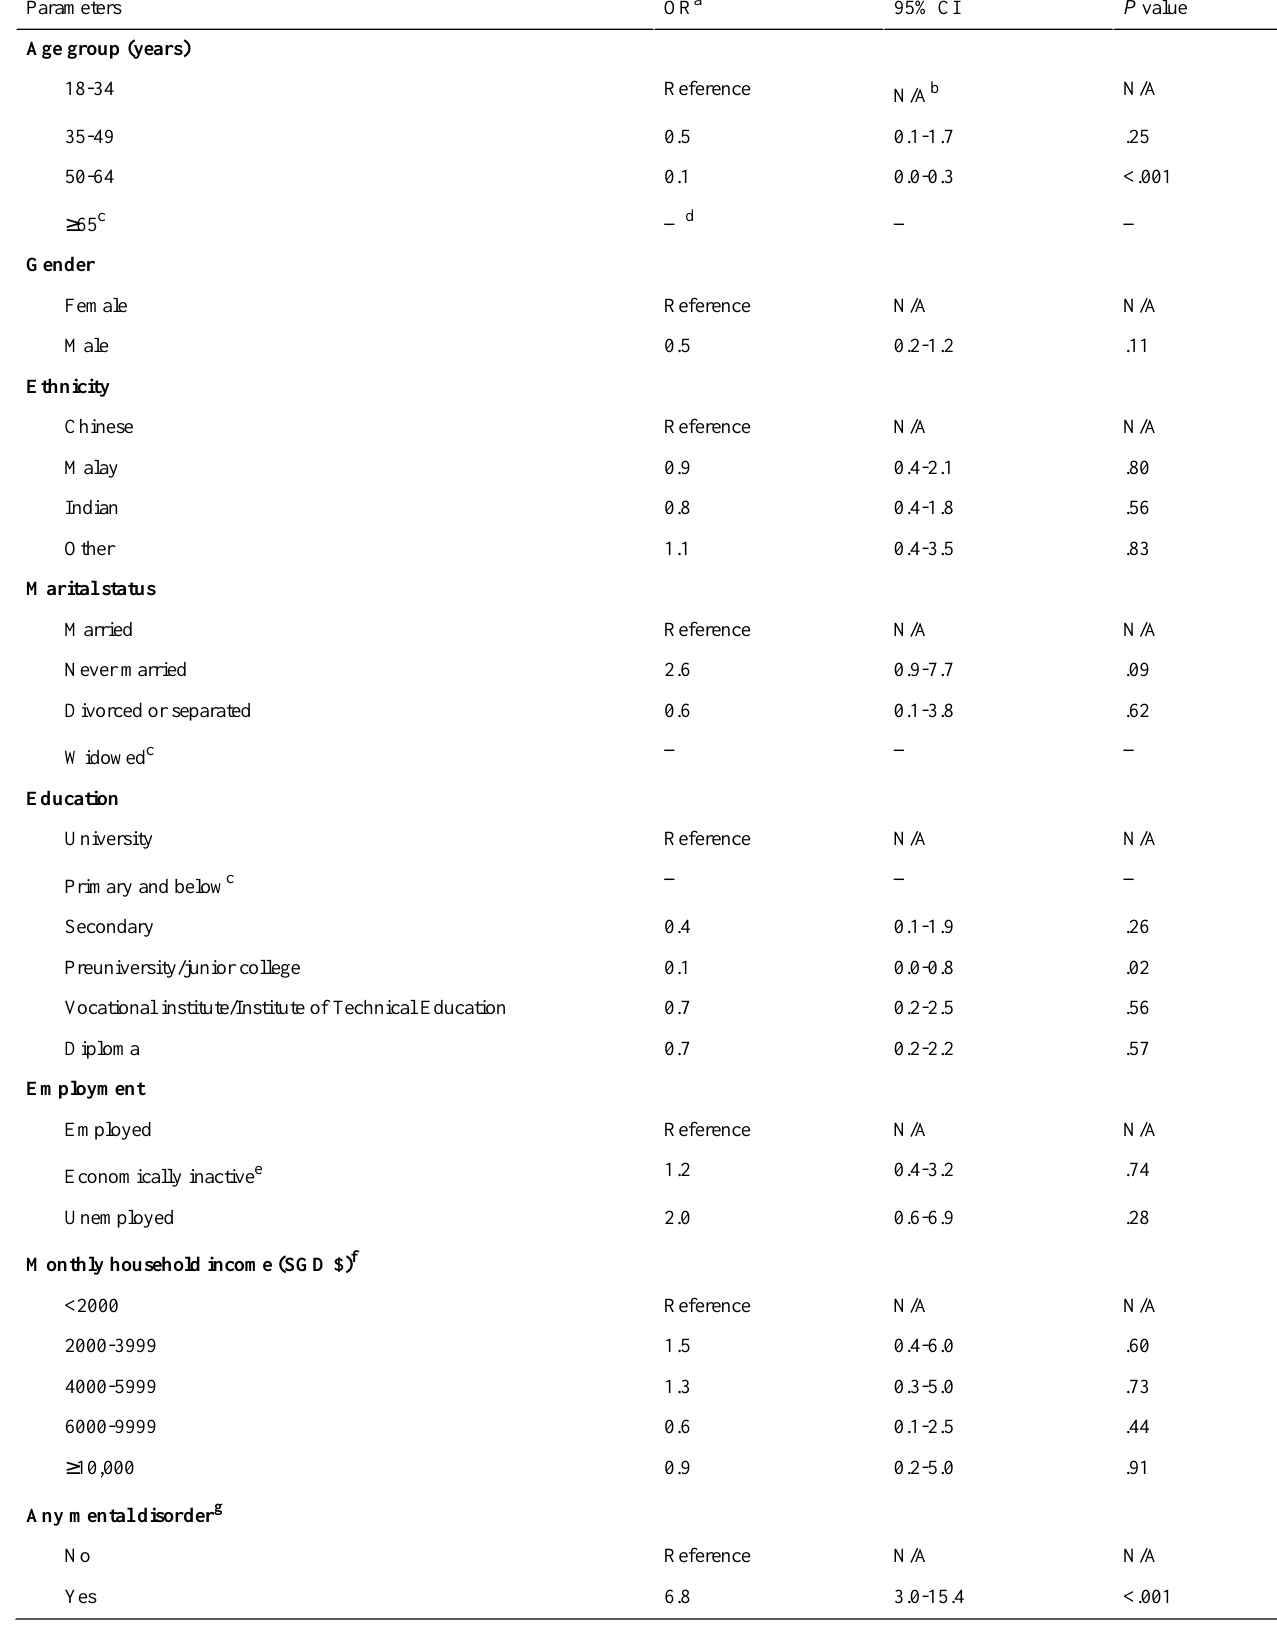
Table 1. Sociodemographic and clinical correlates of online support group